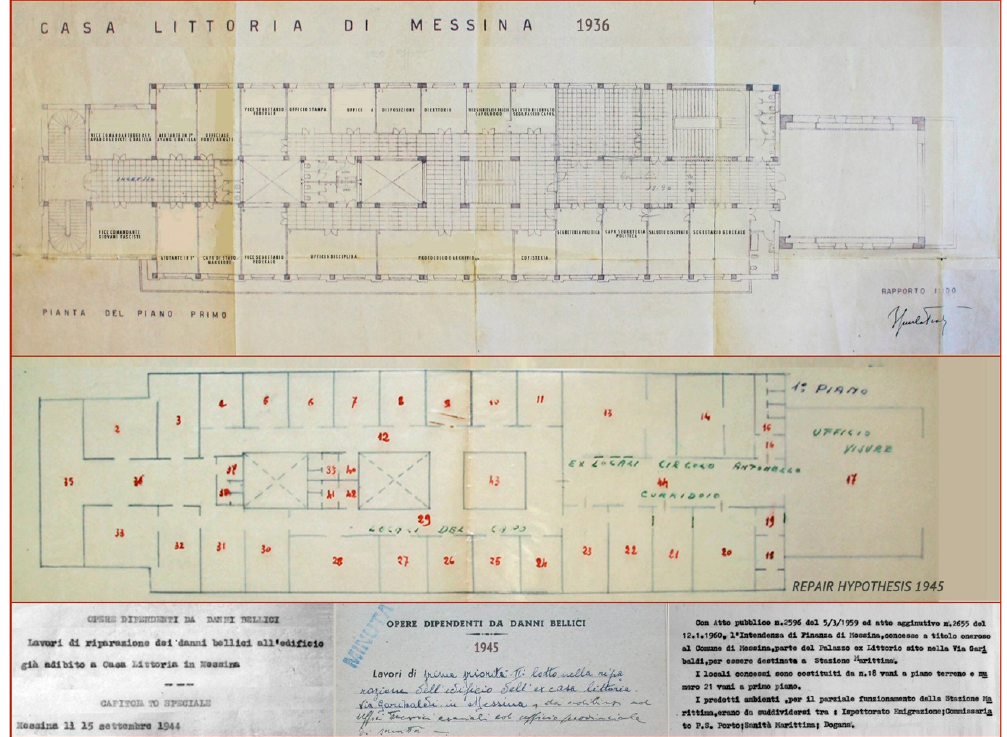
Figure 10. The Fascist House (block VII): hypotheses of post-war utilitas transformations for the first floor. (Above) Original design. (Centre) Sketch from the 1945 Measurement Works Book. (Lower) Excerpts from archive documents "Reproduced with permission from Archivio di Stato [19] and Archivio Genio Civile [23], 2023”.